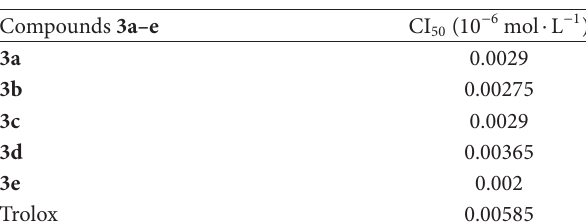
T 5: e EC 50 values exhibited by 2-amino-3-ethoxycarbonyl- 4-(aryl)-4H-pyrano-[3,2-c]-chromene-5-ones 5